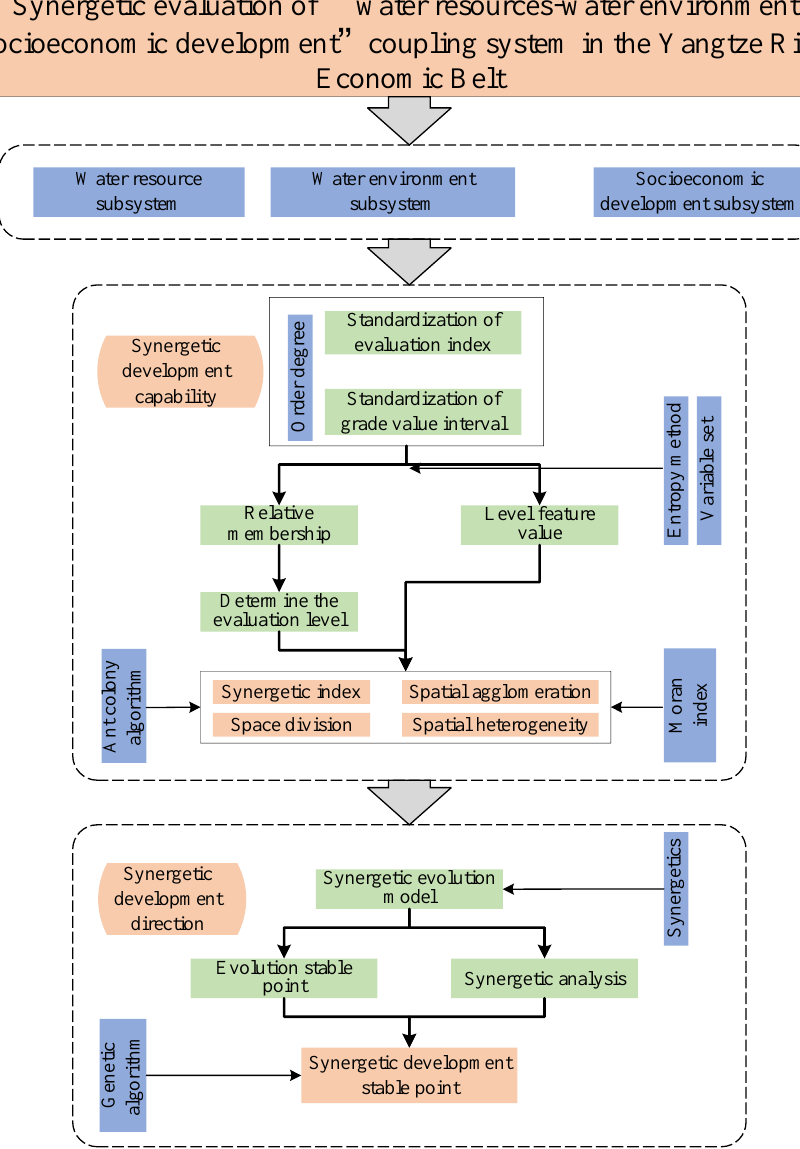
Figure 4. Technology roadmap of this study.